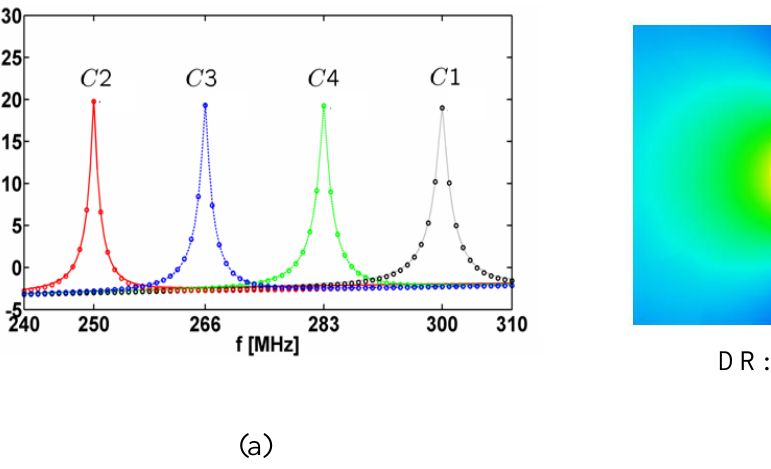
Figure 3. The quantity | R |log10RR  [dB] as a function of frequency for the resonant t 10 1-cylinder structures ( a ), and the magnitude of the electric field of the resonant 2 C ( 250 MHz) 1-cylinder structure for 250  f MHz ( b ). In all cases, each of the individual cylinders are centered at the origin and the ELC is located at )0,mm5.2(),( o   . The electric field in ( b ) is depicted in the xy -plane and the , Ckoss linear dynamic range (DR) in V/m is indicated below the figure. Curves representing the circular surfaces of the structure and a left-right arrow, indicating the size scale of the figure, are likewise indicated in